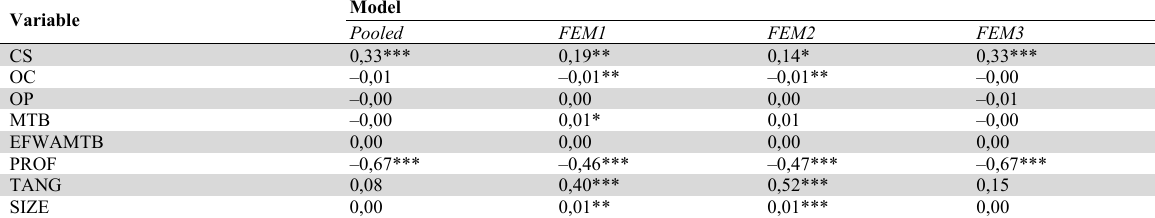
Fixed Effect Model Comparison